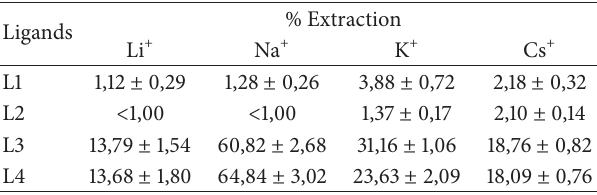
Table 6: Extraction of alkali metal cations with ligands (L1–L4) (%) a .